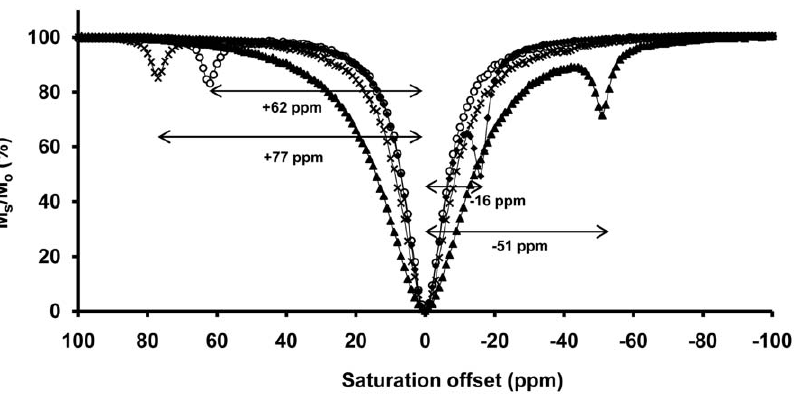
Figure 2. CEST spectra of the four LnDOTA-(gly) 4 complexes. Each complex (20 mM, pH 7.5, 310 K) shows a different amide proton chemical shift with respect to the bulk water ( d H 2 O=0 ppm). The spectra were collected at 9.4 T using a frequency-selective, presaturation pulse over the